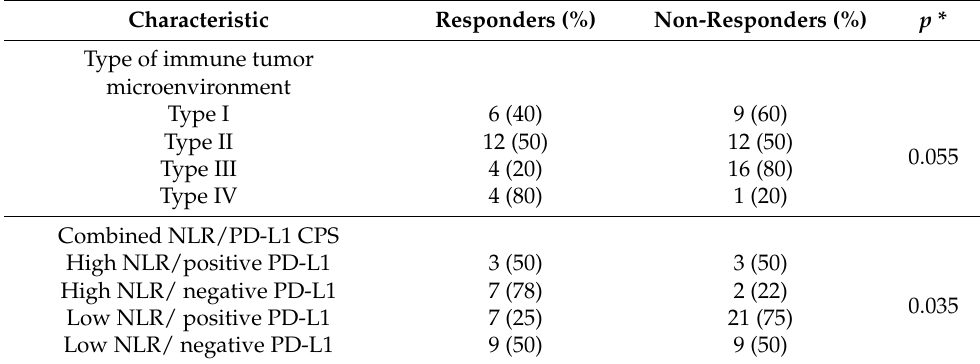
Table 4. The type of immune response to the tumor and the combination of PD-L1 expression and neutrophil-to-lymphocyte ratio (NLR) with the response to induction chemotherapy. Characteristic Responders (%) Non-Responders (%) p * Type of immune tumor microenvironment Type I 6 (40) 9 (60) 0.055Type II 12